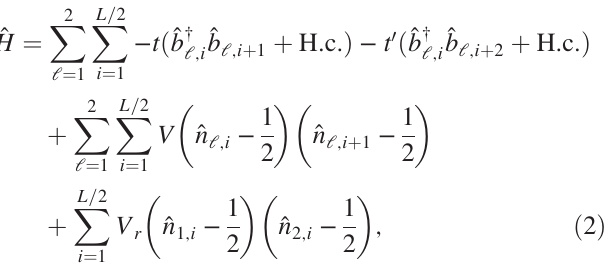
FIG. 4. Thermalization rate data in red versus θ . See Eq. (1) for the definition of the thermalization rate 1 = τ . The gray curve is th the scaling estimate γ 0 2 ð θ Þ U 2 ð θ Þ = ð E c Þ with no free parameters total or offset. Vertical bars and the light blue band indicate standard uncertainty dominate the latter. error; atom number noise and a 3 D Evidently, the thermalization rate in the dipolar quantum Newton ’ s cradle is well described by terms dependent on both the long-range and short-range parts of the DDI, the former through total (intertube plus intratube) U 2 ð θ Þ and the latter total through the intratube DDI dependence of a intra 1 ð θ Þ in γ 0 2 ð θ Þ D